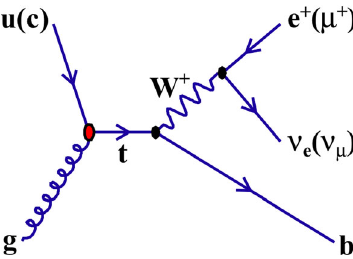
Fig. 1 Leading-order Feynman diagram of non-SM production of a single top quark via the FCNC process u ( c ) + g →